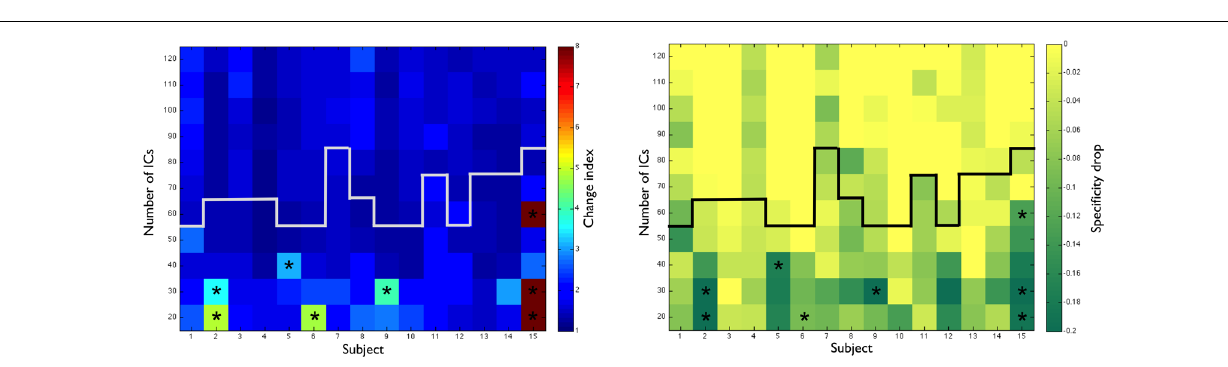
FIGURE 6 | (Left panel) Change index [1/(spatial correlation x temporal correlation)] between the original resting-state IC and ICA dimensionalities from 20 to 120. The white line represents the original dimensionality as determined by MELODIC. (Right panel) Drop in specificity values (specificity at the original dimensionality minus specificity at each new dimensionality). The black line represents the original dimensionality as determined by MELODIC. ∗ Asterisks signal ICs with a change index larger than